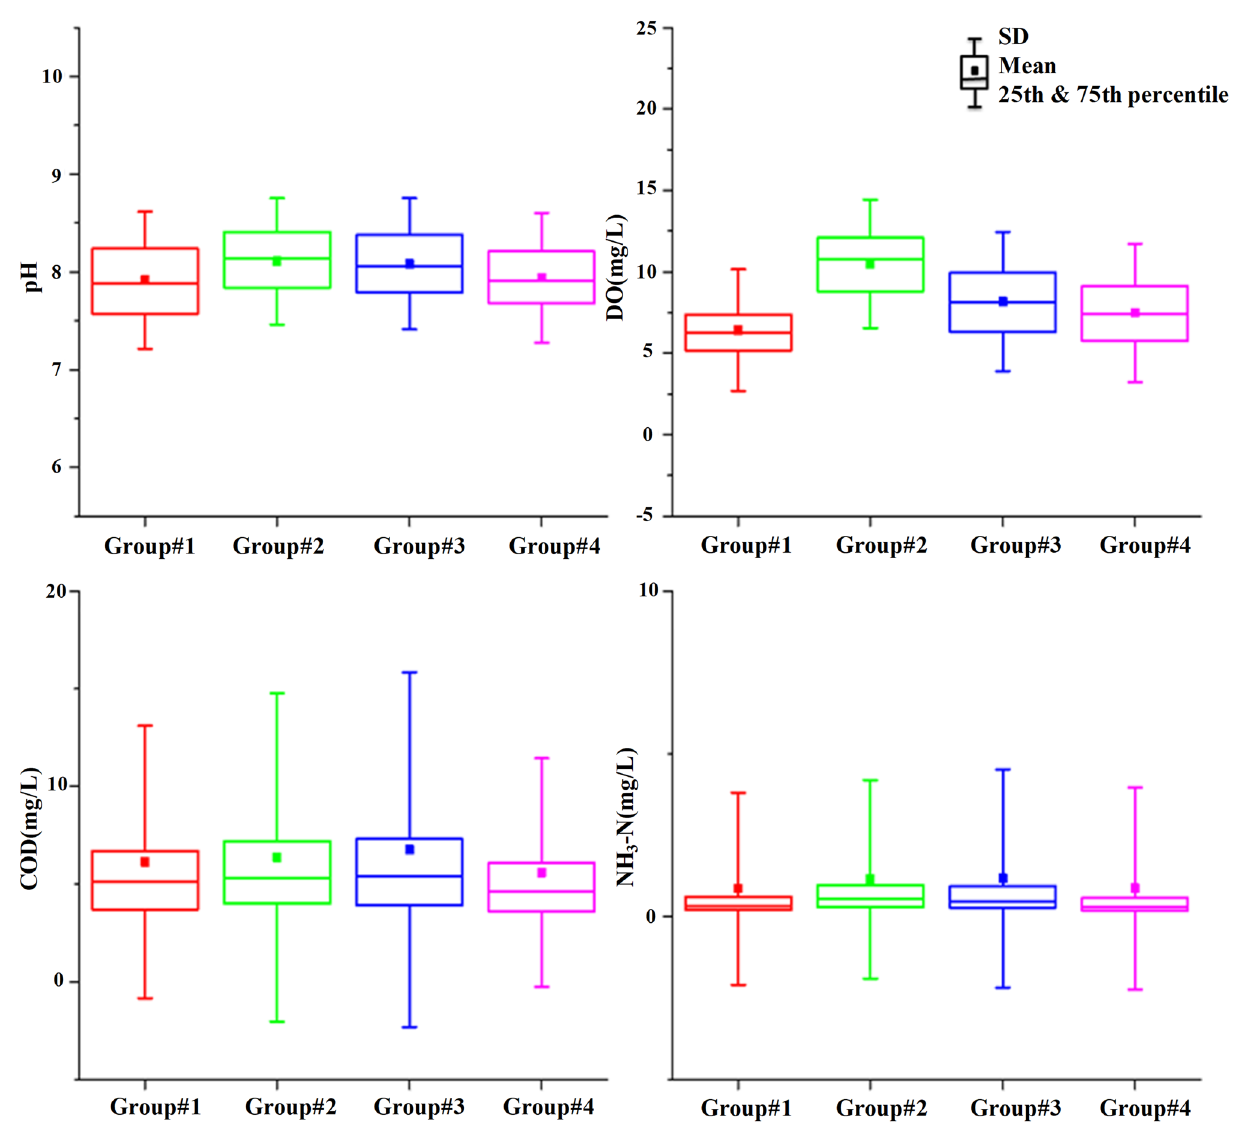
Fig. 6 Temporal variations of water quality parameters for Huaihe River